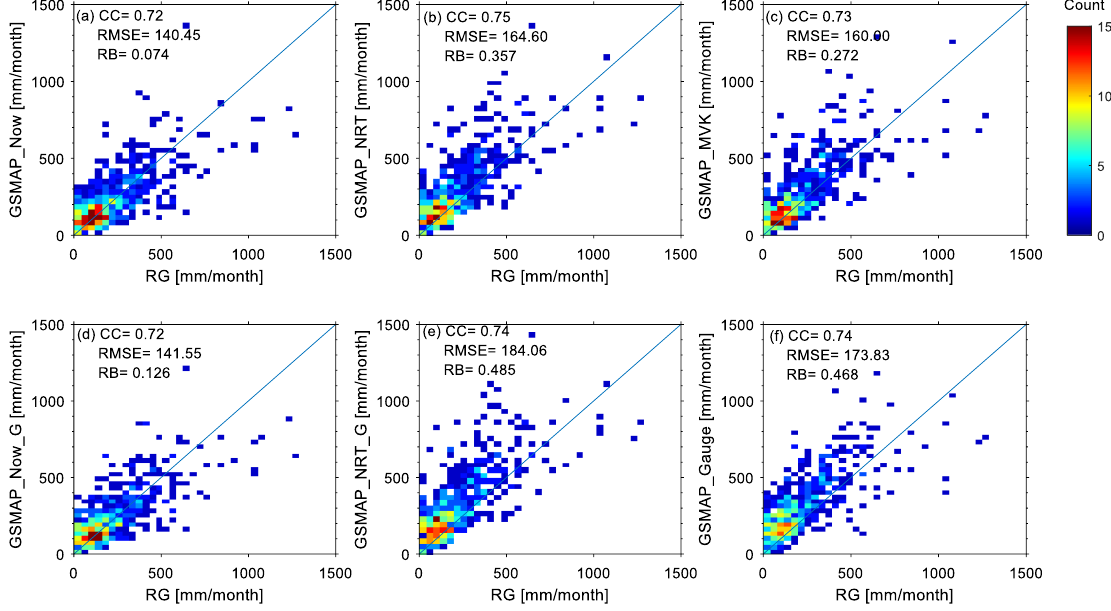
Figure 10. Scatterplot for monthly data of GSMaP_Now (a), GSMaP_NRT (b), GSMaP_MVK (c), GSMaP_Now_G (d), GSMaP_NRT_G (e), and GSMaP_Gauge against RG observations. GSMaP_Now_G ( d ), GSMaP_NRT_G ( e ), and GSMaP_Gauge ( f ) against RG